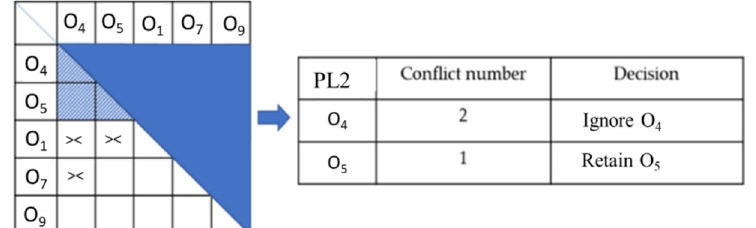
Table 9 The result of solving